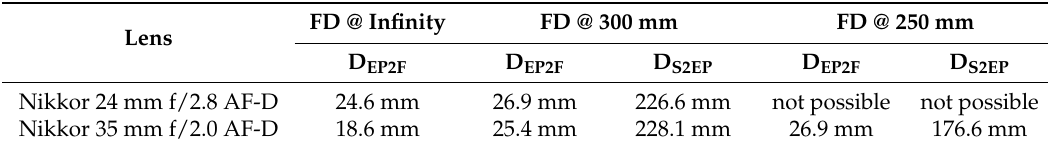
Table 2. Measured distances between flange and entrance pupil distances. FD @ Lens